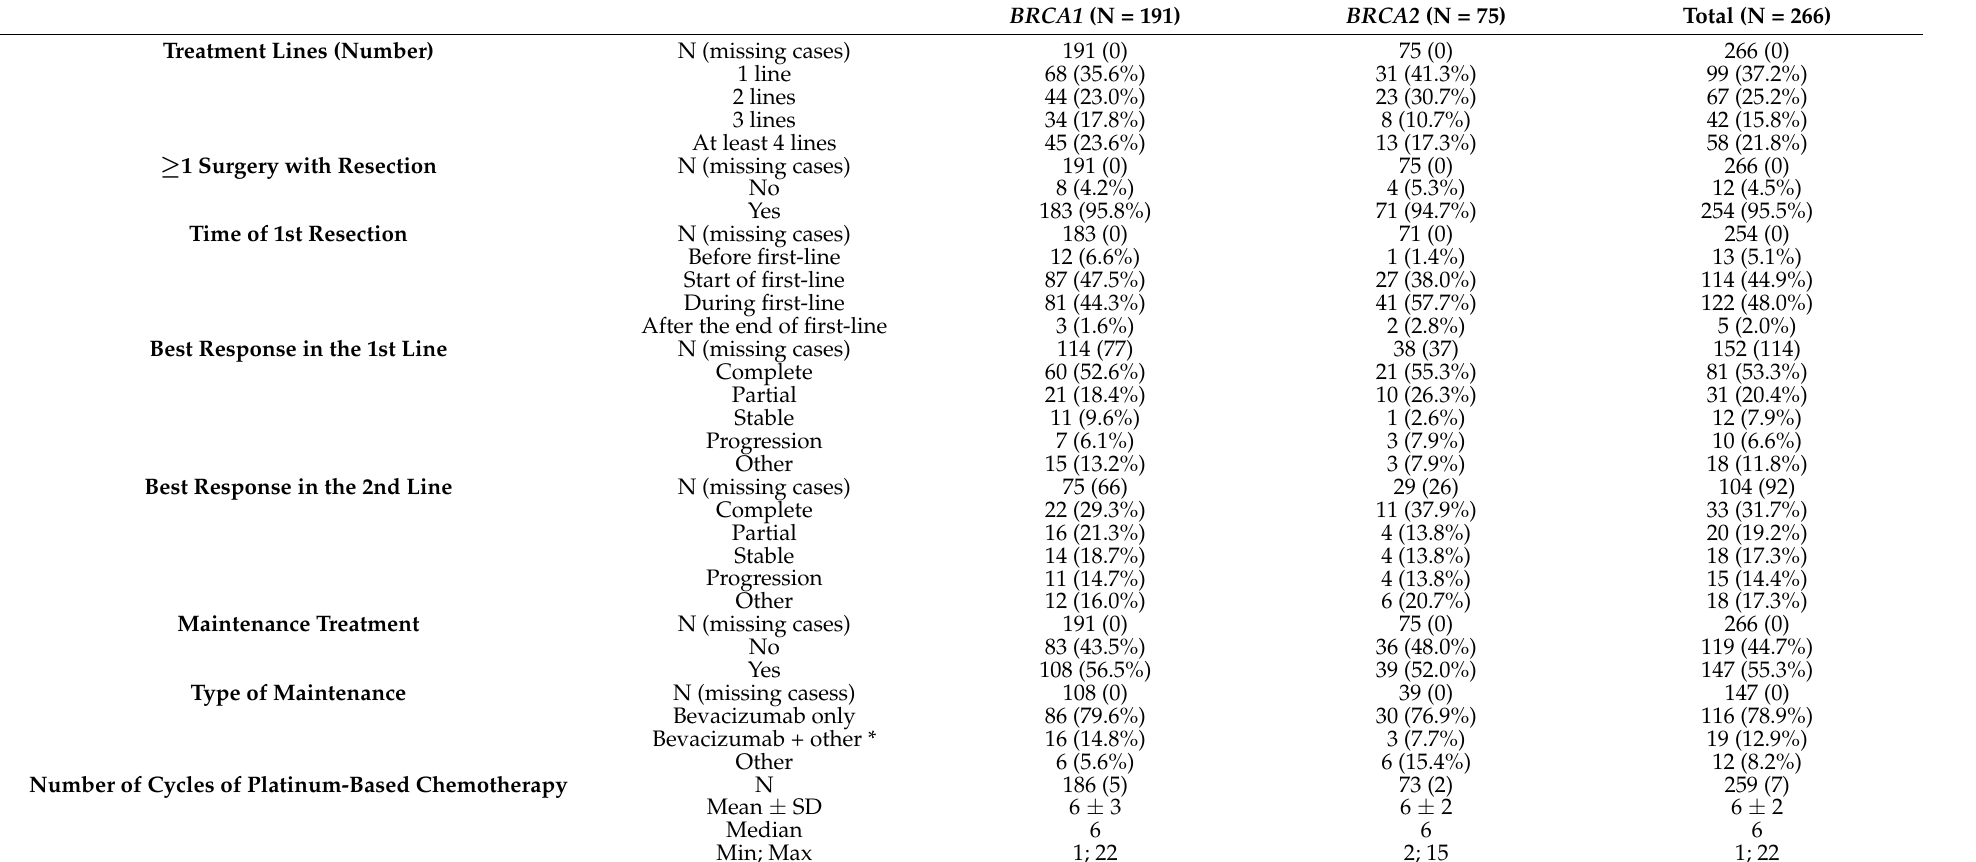
Table 2. Treatment